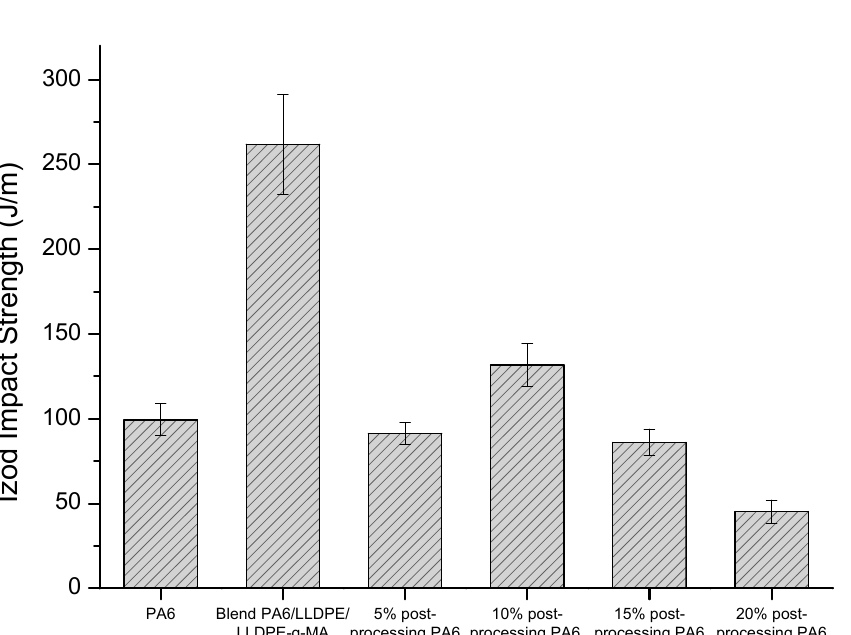
Figure 7. Izod impact strength of the neat PA6 and the PA6 / LLDPE / LLDPE- g -MA blends with di ff erent contents of post-processing Figure 7 . Izod impact strength of the neat PA6 and the PA6/LLDPE/LLDPE- g -MA blends with different contents of post-processing PA6.